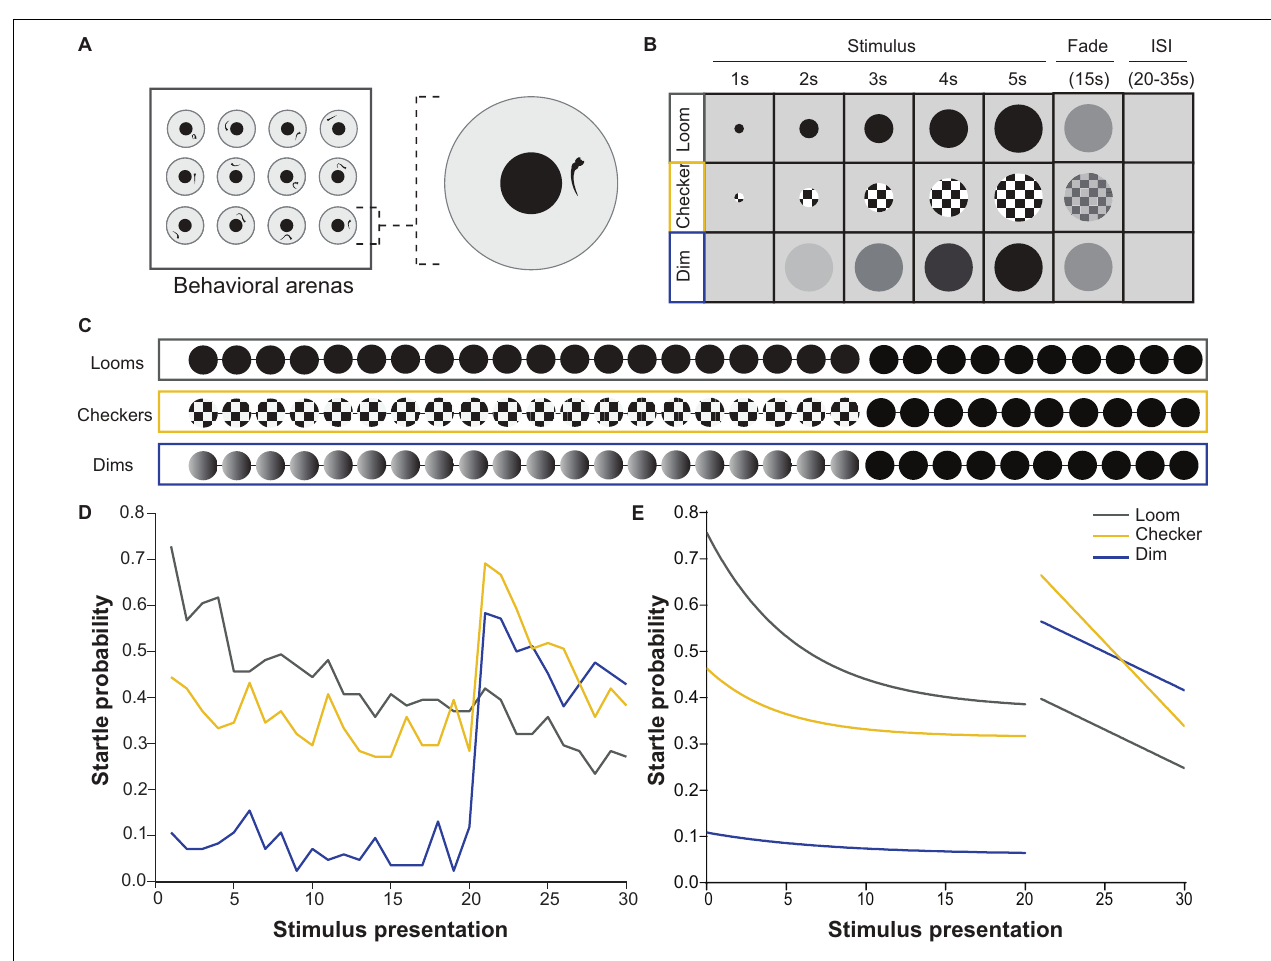
FIGURE 1 | Behavioral responses to repeated loom, checkerboard, and dim stimuli. (A) Experimental set up used for behavioral experiments, where 12 larvae were presented with stimulus trains from a screen below while their movements were recorded with a camera above. (B) Properties and timing of the loom, checkerboard, and dim stimuli. (C) The three stimulus trains used for behavioral experiments, comprising 20 presentations of one stimulus (either loom, checkerboard, or dim) followed by 10 looms, all separated by interstimulus intervals ranging between 20–35 s. (D) The average probability of an escape response during these experiments, across all larvae. Habituation was significant ( p = 4.28E-7) for loom responses, but not for checkerboard ( p = 0.01325535) or dim ( p = 0.8195796, tested with the nparLD R package, using Bonferroni correction for multiple comparisons, adjusting the p -value for significance to 0.00625). Responses to the first loom (21st stimulus) were not significantly different from naive loom responses for animals shown checkerboards ( p = 0.4875) or dims ( p = 0.05995, tested with a Mann–Whitney U test, using Bonferroni correction for multiple comparisons, adjusting the p -value for significance to 0.00625). (E) Fitted curves to the average probability of escape response shown in panel (D) illustrate the habituation profile to each stimulus